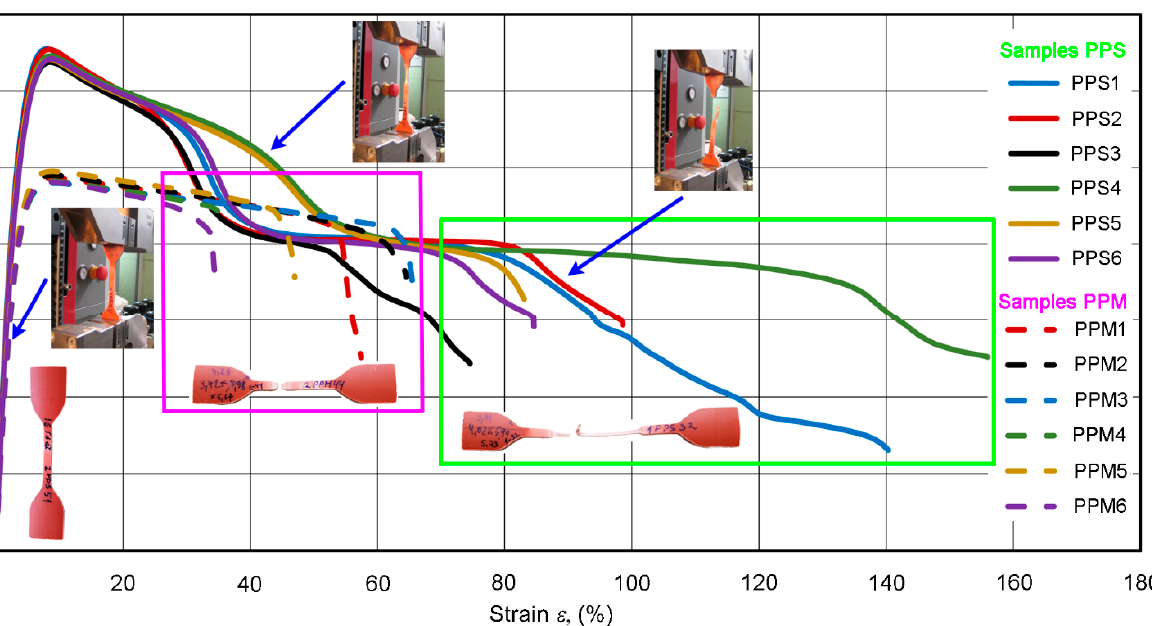
Figure 8. An enlarged view of the initial section of tensile stress—strain curves of typical PPS and PPM specimens. The inclined straight lines are secants at a 0.3–1.5% elongation, but the horizontal straight lines determine the value of σ max .